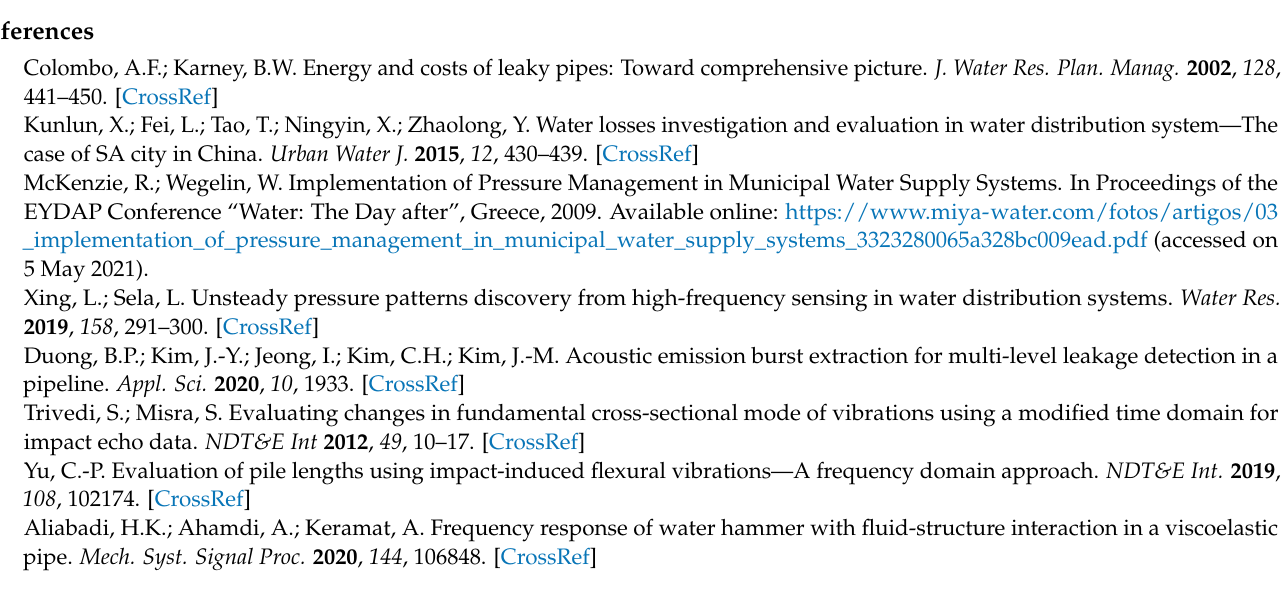
Figure A1. Comparison with CWTs of wavelets; ( a ) Haar, ( b ) Coiflet 1, ( c ) Gauss 1, ( d ) Daubechies 2, ( e ) Symlet 2, ( f ) Mexican Hat, ( g ) Daubechies 6, ( h ) Meyer, ( i ) Morlet (white dotted line stands for the true time, and red dotted lines are peak tracking lines of each wavelet’s CWT).